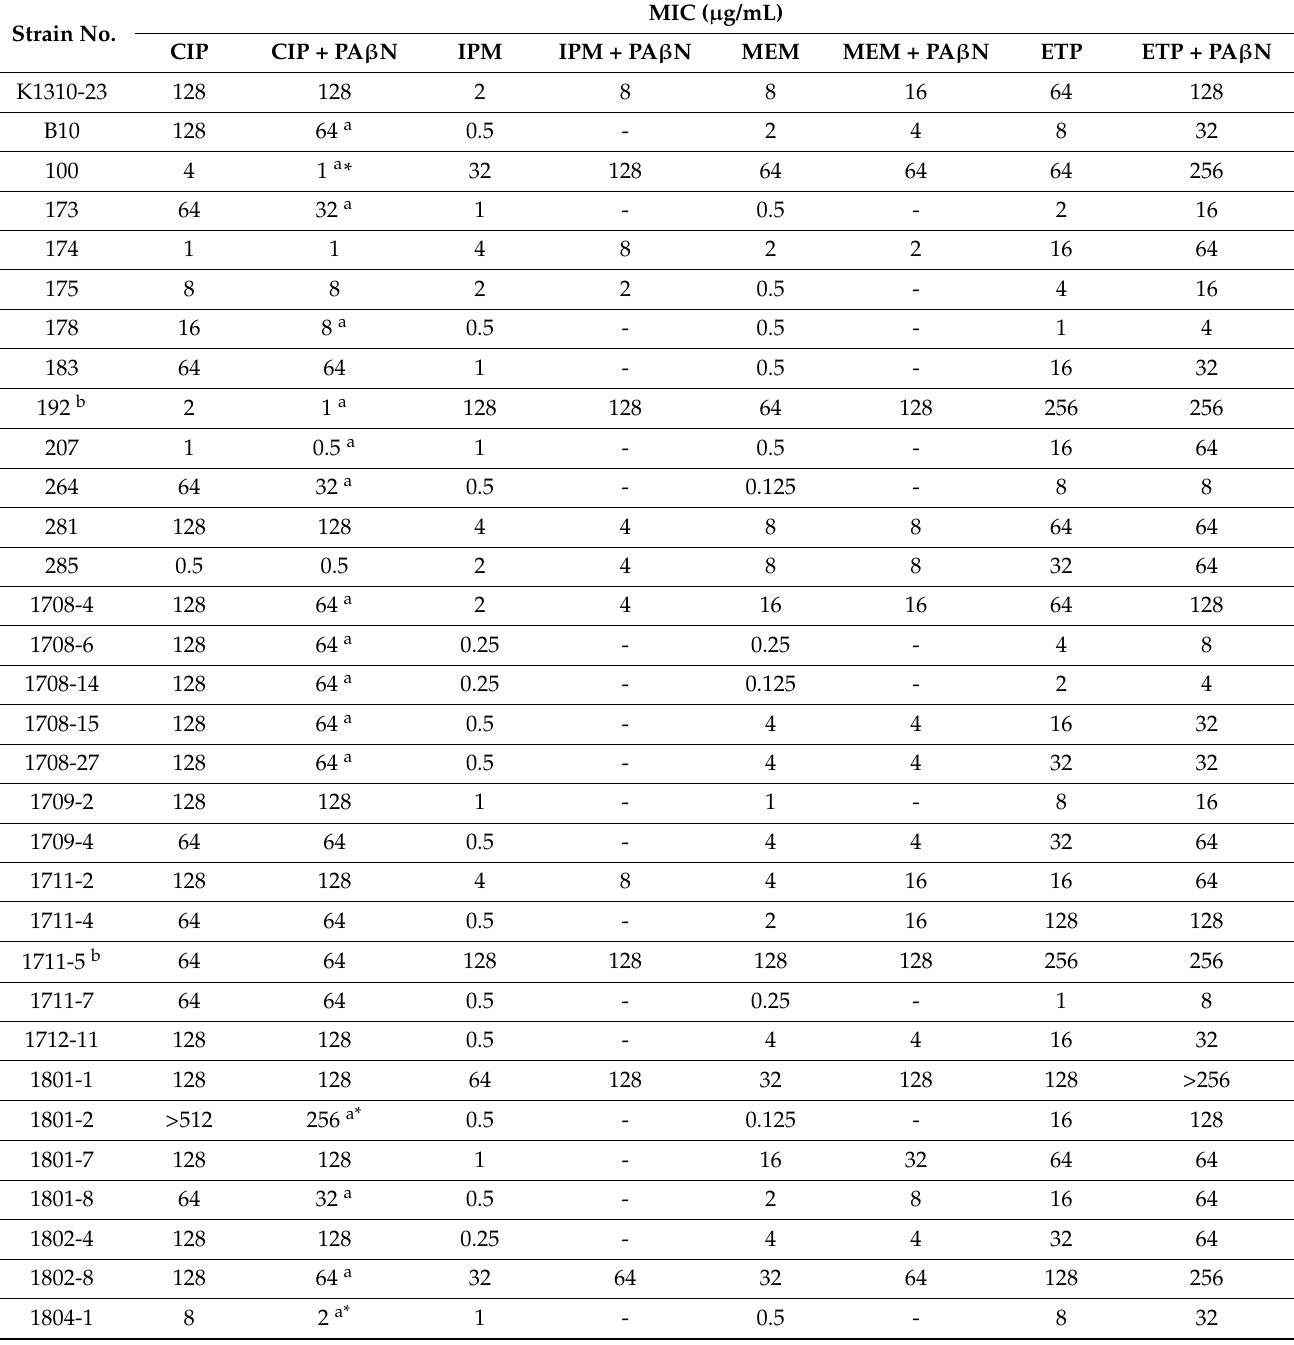
Table A1. MIC of carbapenem and ciprofloxacin in the absence and presence of the efflux